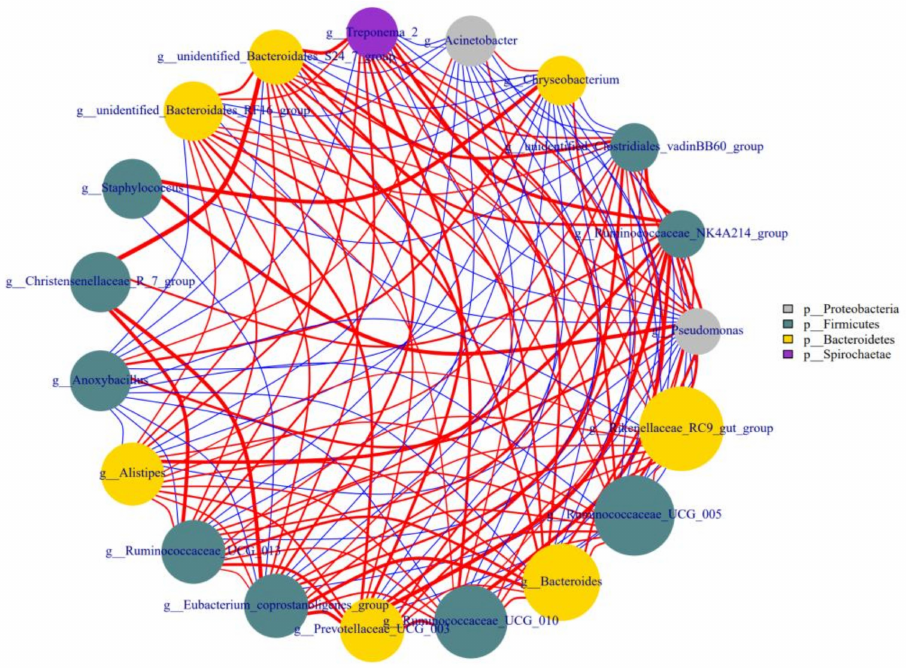
Figure 5. Network analysis of association of microbiota at the genus level in colostrum. Note: The number of colostrum samples for this analysis was